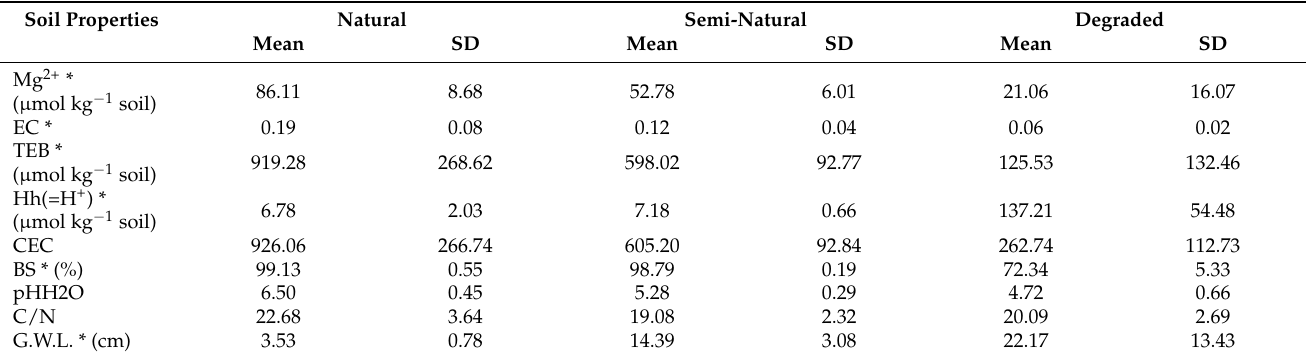
Table 3. Soil characteristics of mountain fen sites of Caltho-Alnetum in different hydrologic conditions (HC). Values presented in the table are means across replicates of each site (n = 3) with standard devi- ation ( ± SD). Mg 2+ —Mg 2+ cation concentration; EC—electrical conductivity; TEB—total exchange- able base cations; Hh—hydrolytic acidity; CEC—cation exchange capacity; BS—base saturation; G.W.L.—ground water level; (n = 6).